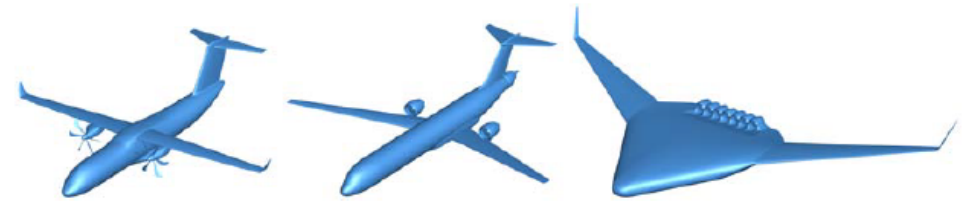
Figure 2. A family of energy-efficient aircraft under the Se 2 A